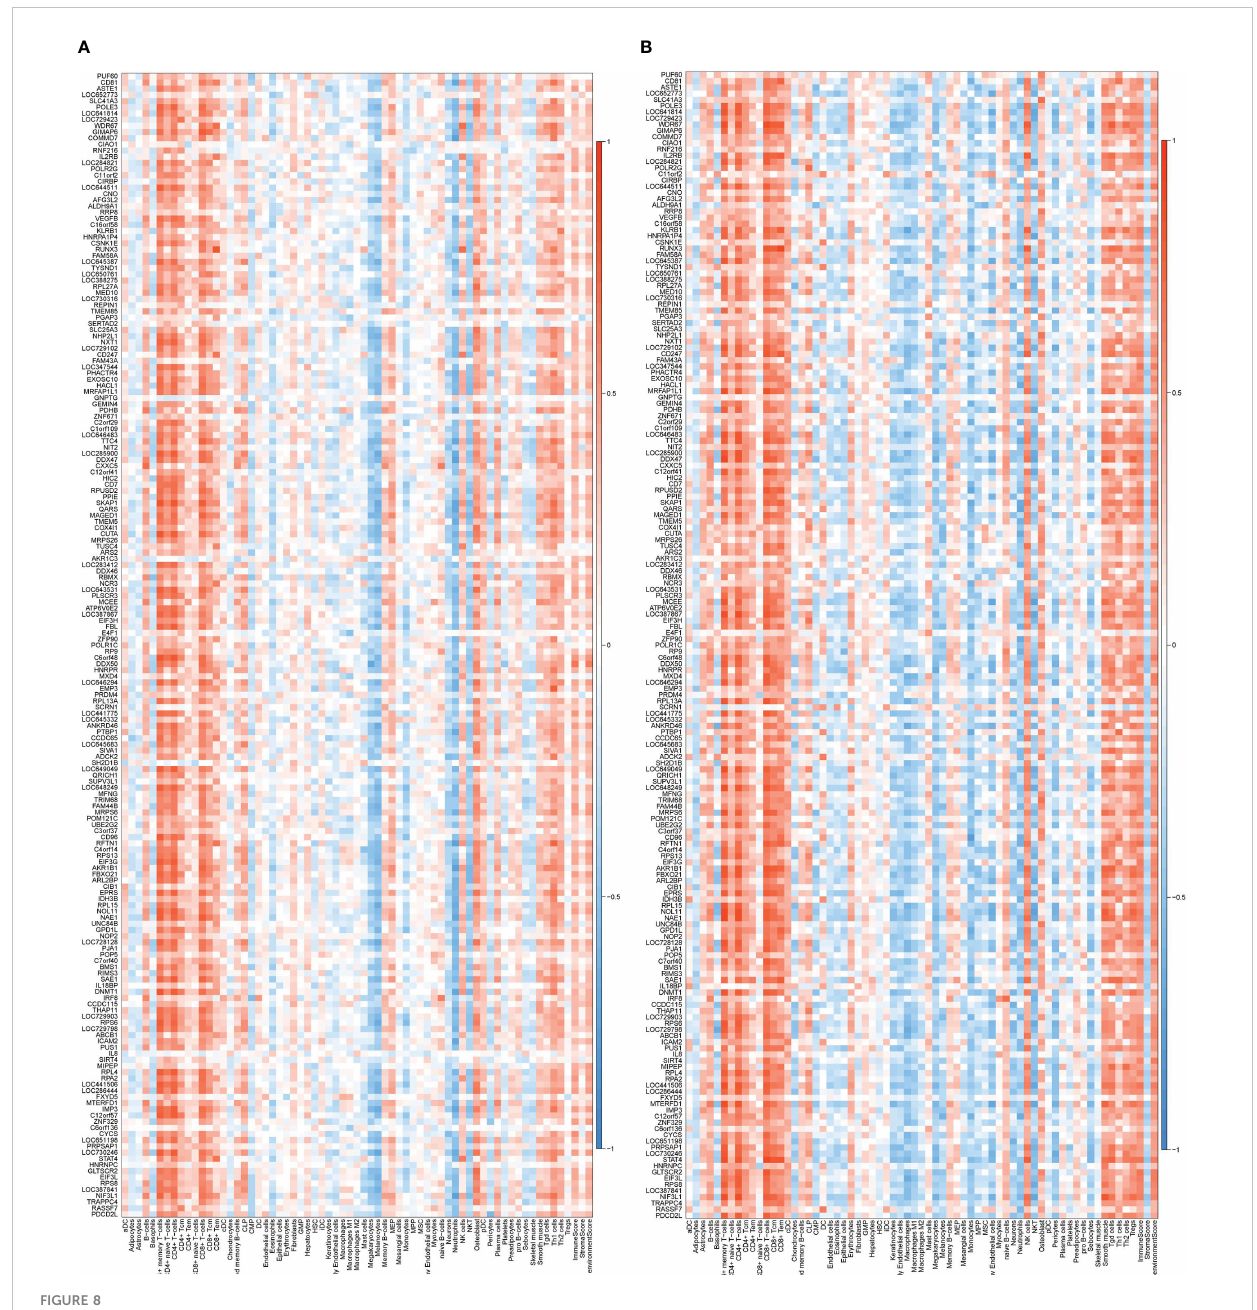
FIGURE 8 Correlation between down-regulated coDEGs and immune cells (A) Correlation between down-regulated coDEGs and immune cells in AS. (B) Correlation between down-regulated coDEGs and immune cells in